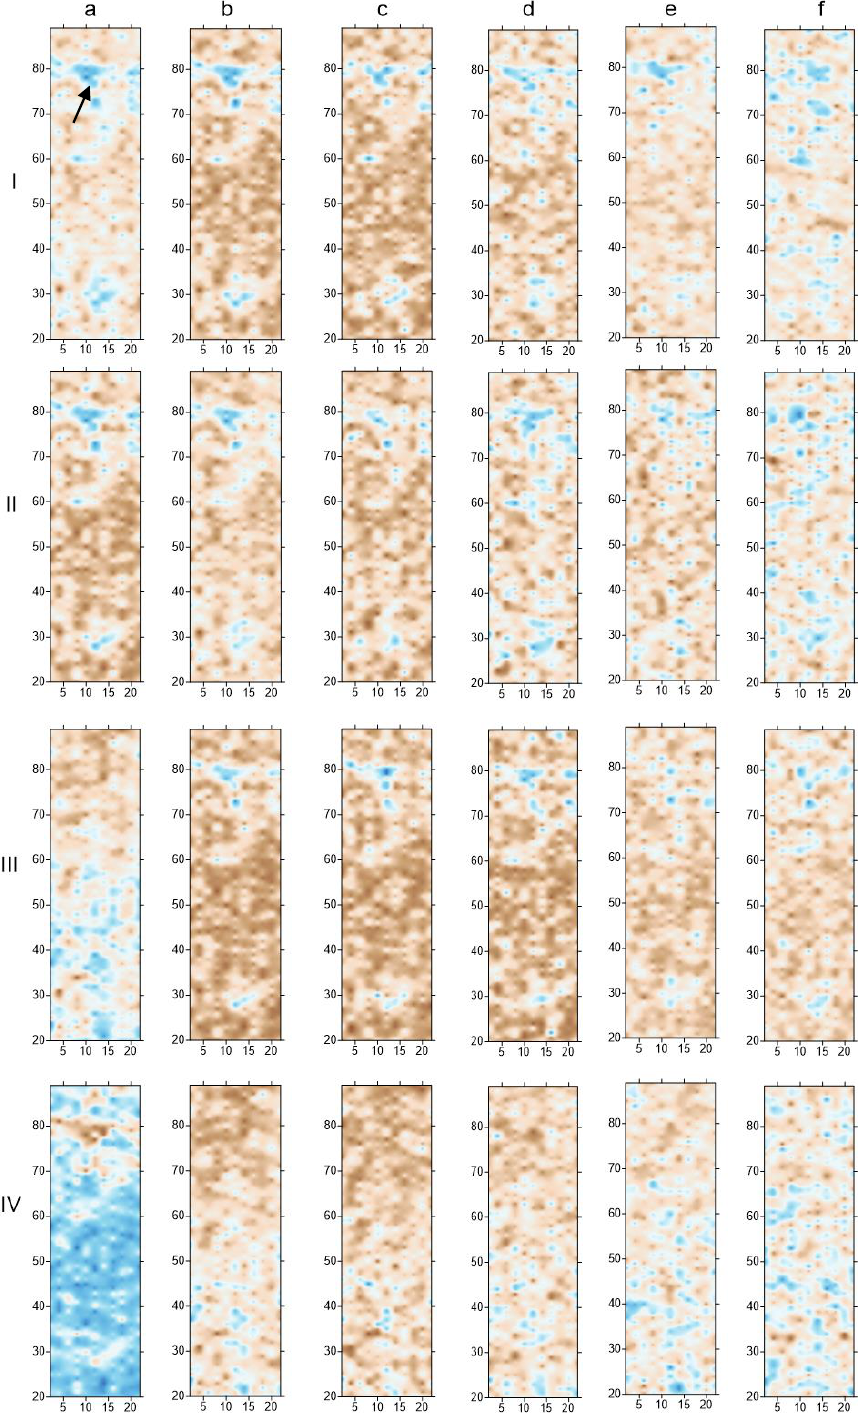
Figure 3. Column a : Reflectance of spectral bands; Column b : Reflectance of spectral bands with random noise of level 0.1 of the standard normal distribution; Column c : Reflectance of spectral bands with random noise of level 0.2 of the standard normal distribution; Column d : Reflectance of spectral bands with random noise of level 0.3 of the standard normal distribution; Column e: Reflectance of spectral bands with random noise of level 0.4 of the standard normal distribution; Column f : Reflectance of spectral bands with random noise of level 0.5 of the standard normal distribution. Row I : Blue band (Band 1); Row II: Green band (Band 2); Row III : Red band (Band 3) and Row IV: Near Infrared (NIR) band (Band